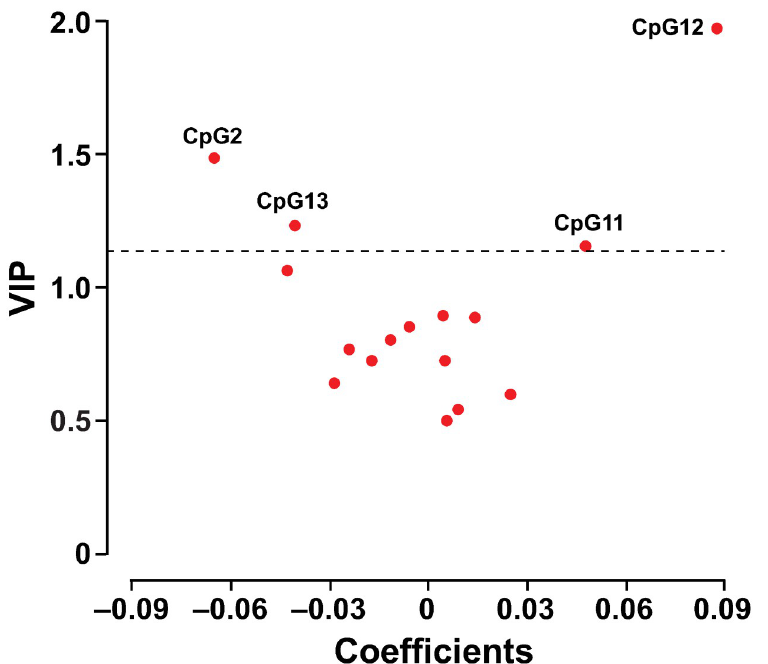
Fig 4. V-plots of variable importance in projection (VIP) scores against the centred and rescaled correlation coefficients generated by partial least-squares discriminant analysis. The VIP score indicates the importance of the methylation level at each site in the construction of the partial least-squares latent factors. The centred and rescaled correlation coefficients reflect the associations of colorectal cancer with the methylation level. The risk of colorectal cancer was standardised to the average (ratio or mean) in the whole study population of sex, age, body mass index, the ratio of total to high-density lipoprotein serum cholesterol, serum creatinine, smoking and drinking, the use of antiplatelet agents, and the time interval between the methylation measurement and diagnosis of colorectal cancer in cases or last follow-up in non-cases. Markers in the top left quadrant and top right quadrant of the V plot were respectively associated with lower and higher risk of colorectal